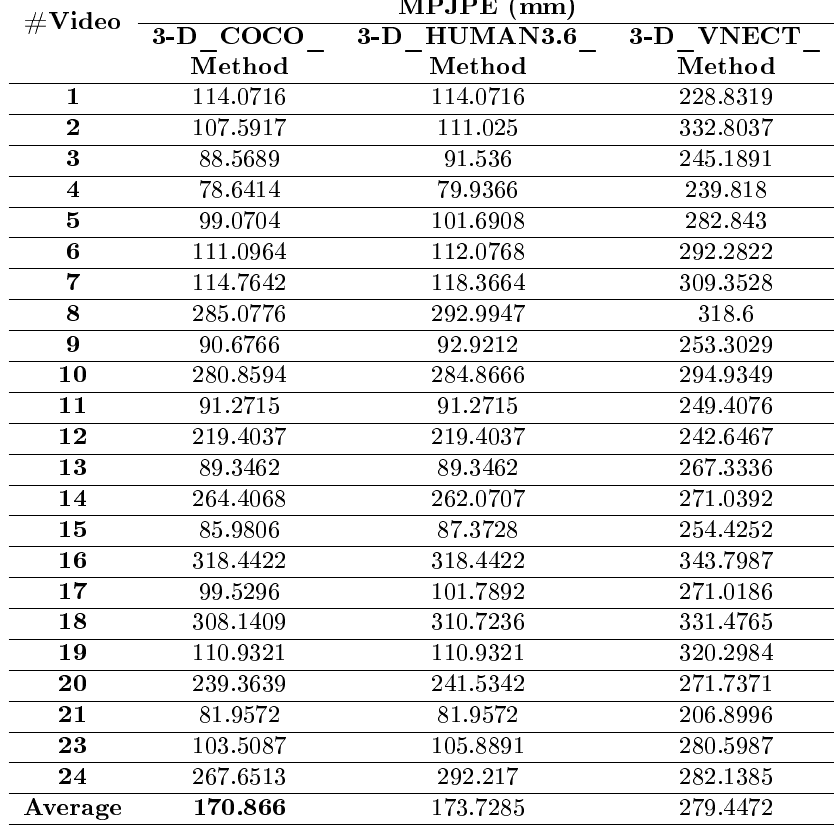
Tab. 5: The results of 3-D human pose estimation on the VNMA dataset with 15 key